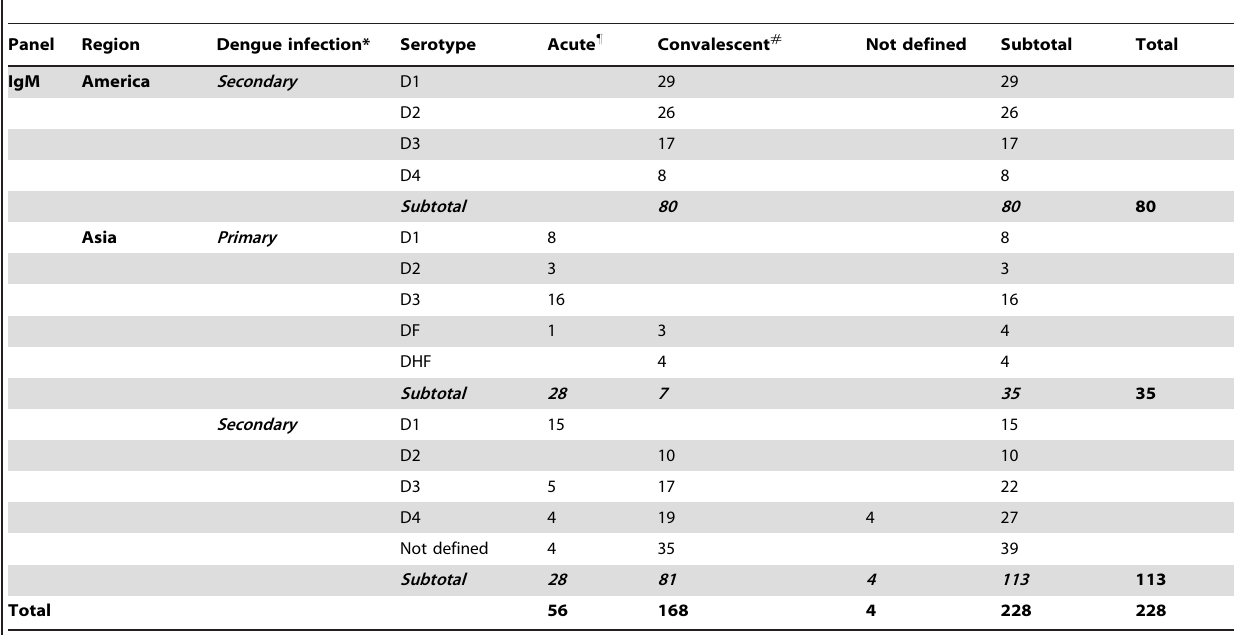
Table 2. Characteristics of specimens from dengue patients included in the panel to evaluate anti-DENV IgM detection kits.